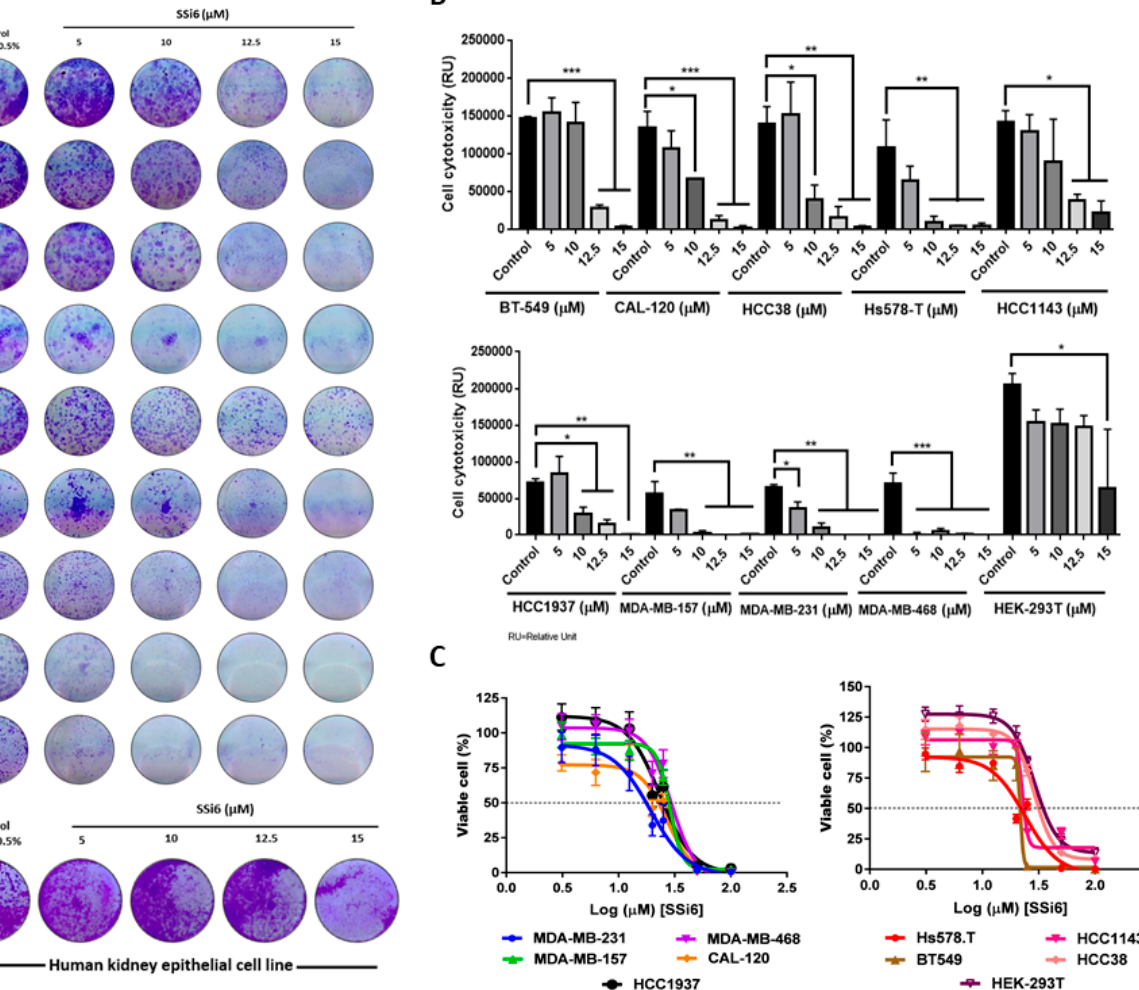
Figure 1. Cytotoxic effects of SSi6 on a panel of triple-negative breast cancer (TNBC) cells. ( A ) TNBC cells were seeded in 12-well plates and treated with indicated concentrations for 10 days steadily. ( B ) Graphs represent the relative cytotoxicity unit of SSi6 in TNBC cells. HEK-293T is a human embryonic kidney cell line, used for comparations of the cytotoxic effect of SSi6 in non-tumor human cells. The data represent the mean ± standard deviation of three independent tests in triplicate. The results were compared using one-way ANOVA, followed by Bonferroni’s analysis; * p < 0.05, ** p < 0.001, *** p < 0.0001. Effects of SSi6 on cell viability (CellTiter, MTS). Cells were plated in 96-well plates and incubated with different concentrations of SSi6, the vehicle was treated with 0.5% DMSO for 72 h. ( C ) IC 50 plot on TNBC and HEK-293T cell lines treated with SSi6 concentrations. Data show mean ± SD of three independent